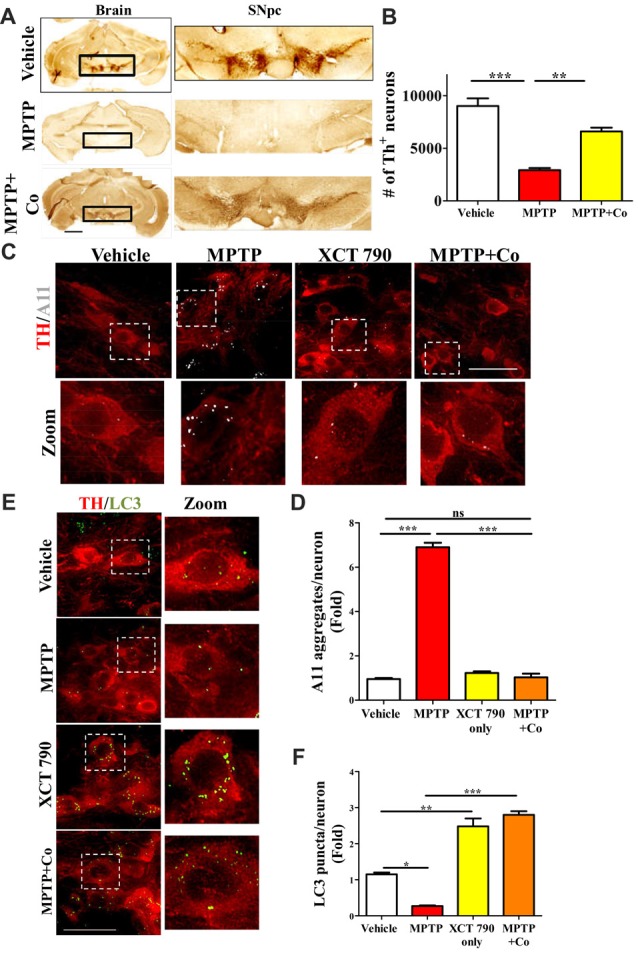
XCT 790 is neuroprotective by degrading toxic protein aggregates through inducing autophagy in dopaminergic neurons of midbrain of mice. (A) Representative photomicrographs of whole brain and SNpc for various cohorts namely vehicle, MPTP (23.4 mg/kg of body weight) and MPTP+Co (Co-administration of MPTP and XCT 790: MPTP; 2 mg/kg of body weight and XCT 790; 5 mg/kg of body weight, n = 4 animals per cohort). Scale bar is 600 μm. (B) Graph representing the unbiased stereological quantification of tyrosine hydroxylase (TH)-ir dopaminergic neurons in SNpc for above mentioned cohorts. Statistical analysis was performed using one-way ANOVA and the post hoc Bonferroni test. Error bars, mean ± SEM. **P < 0.01, ***P < 0.001. (C) Representative IHC photomicrographs of SNpc dopaminergic neurons double stained for A11 (toxic oligomer marker) and TH (dopaminergic marker) antibodies for the above-mentioned cohorts (n = 4 animals per cohort). Scale bar is 50 μm. (D) Plot indicating the A11 puncta per dopaminergic neuron in SNpc was quantitated for all cohorts. Statistical analysis was performed using one-way ANOVA and the post hoc Bonferroni test. Error bars, mean ± SEM. ns-non significant, ***P < 0.001. (E) Representative fluorescent IHC photomicrographs of dopaminergic neurons in SNpc double stained for LC3 (autophagy marker) and TH (SNpc marker) antibodies for various cohorts namely vehicle, MPTP, XCT only and MPTP+Co (n = 4 animals per cohort). Scale bar is 50 μm. (F) Graph representing the LC3 puncta per neuron for various cohorts. Statistical analysis was performed using one-way ANOVA and the post hoc Bonferroni test. Error bars, mean ± SEM. ns-non significant, *P < 0.05, **P < 0.01, ***P < 0.001.